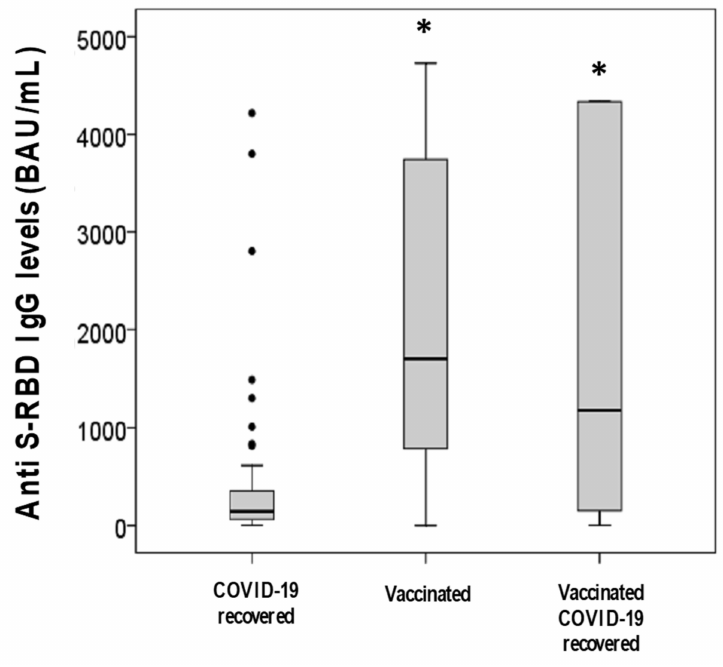
Figure 2. Anti S-RBD IgG levels in the three groups investigated * p < 0.001 vs. “COVID-19 recovered” group, Bonferroni’s